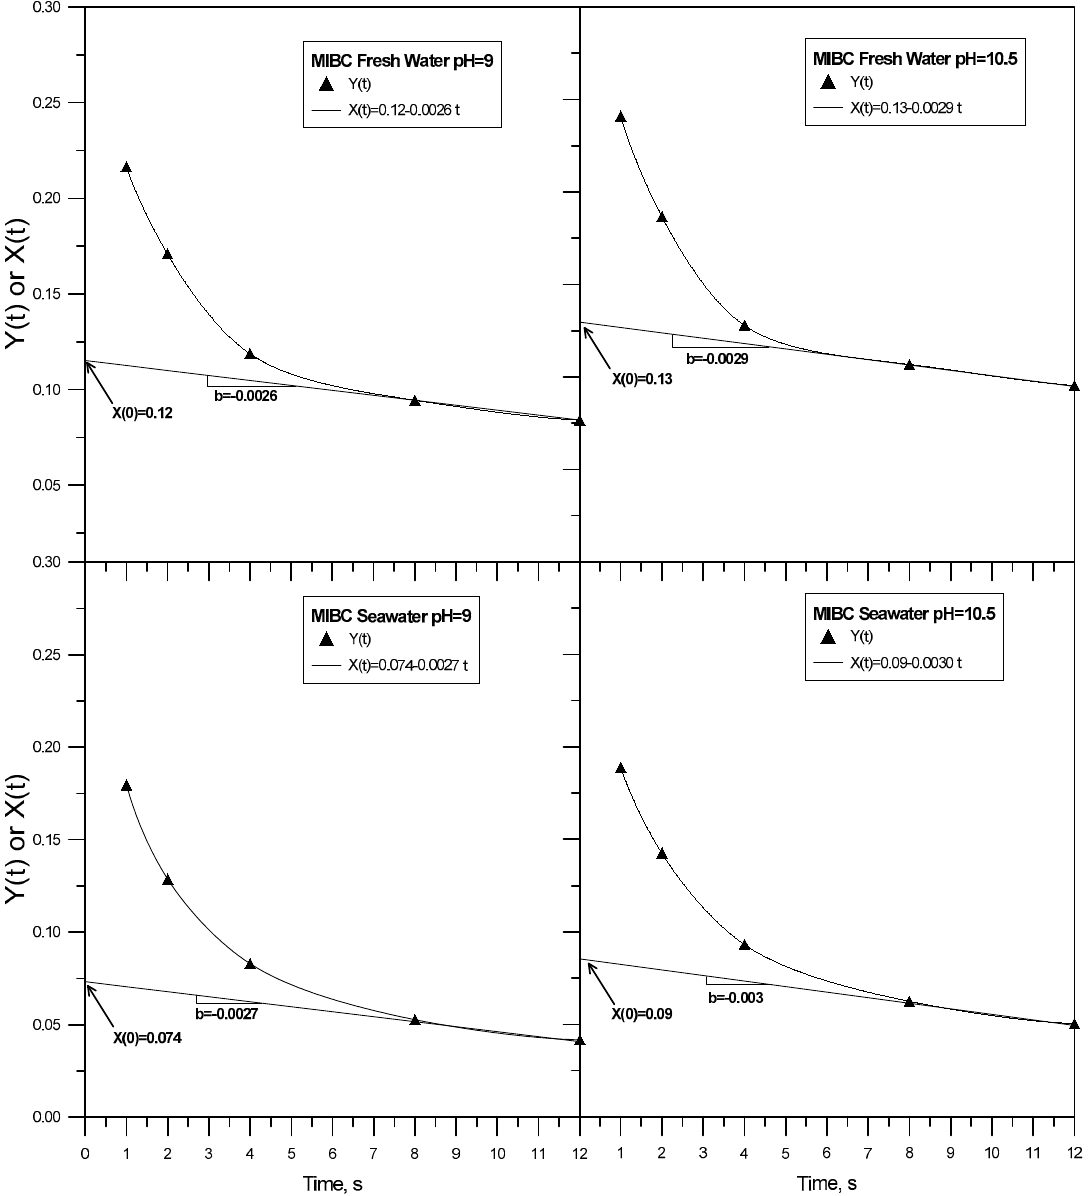
Figure 5. Y(t) and X(t) as a function of time. The tests were done in fresh and seawater, at pH 9 and 10.5, and using MIBC.